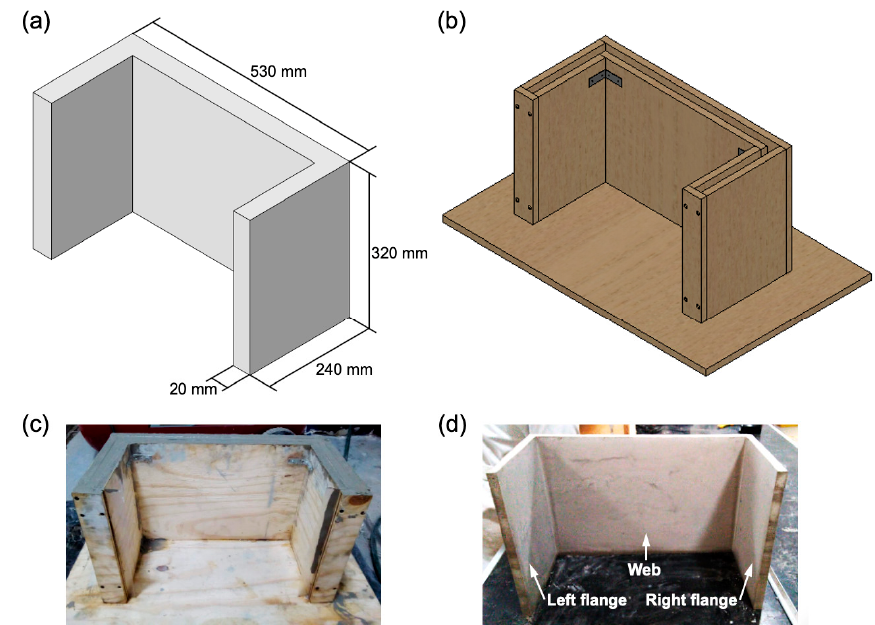
Figure 3. ( a ) Schematic of the U-shaped wall showing the geometrical details; ( b ) schematic of the wooden mold; ( c ) foamed concrete casting; and ( d ) U-shaped wall specimen.